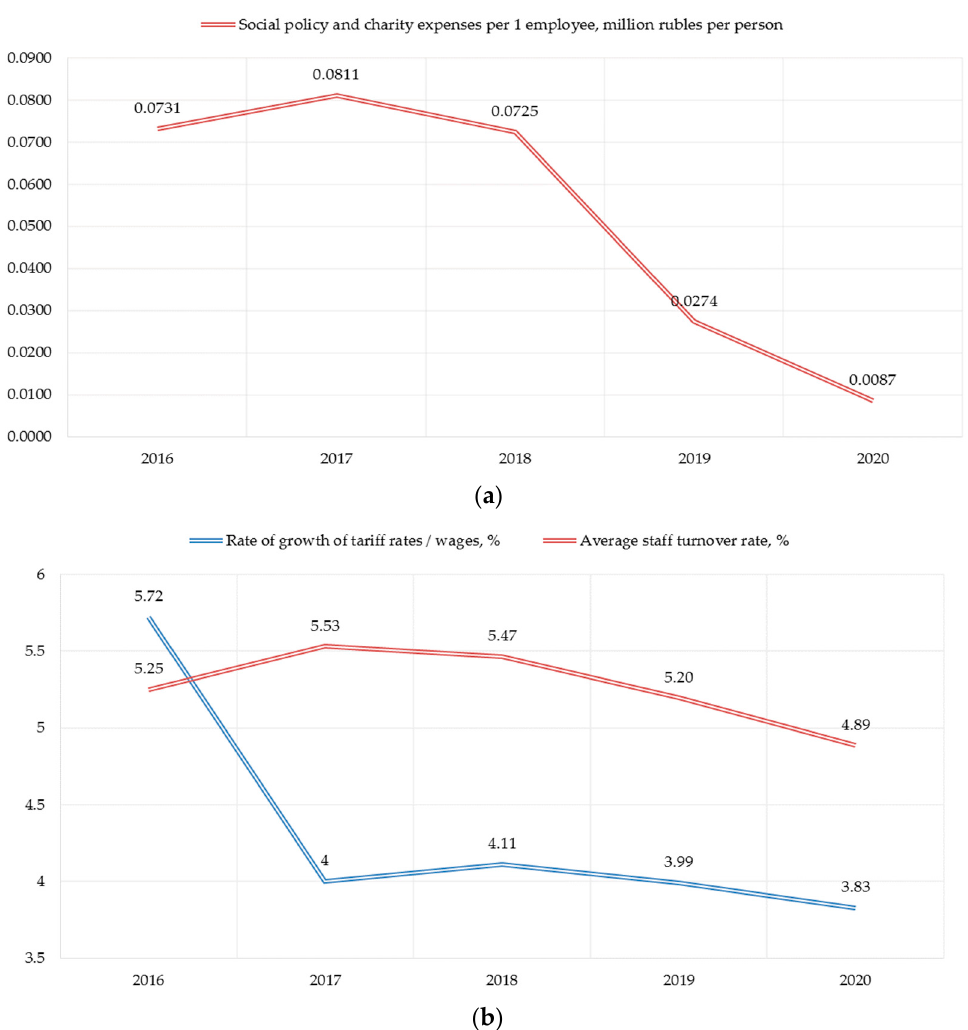
Figure 3. Sub-indices of assessing the social factor of PJSC «Nizhnekamskneftekhim» sustainable development: ( a ) Social policy costs, million rubles per person; ( b ) Wages and staff turnover rate.